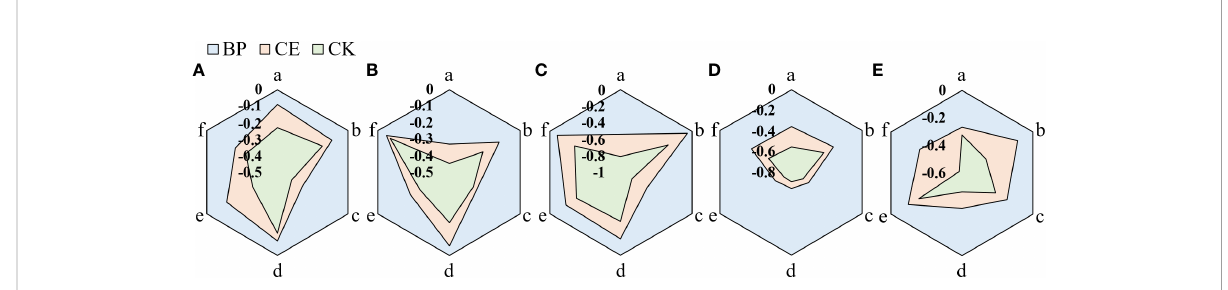
FIGURE 7 Allelopathic effect index of root exudates of Maize on the growth of seedlings of recipient plants. (A – E) shows the allelopathic effect index of CE and CK root exudates on the growth of radish, cucumber, lettuce, pepper, and ryegrass respectively. (a – f) in the fi gure respectively represent the allelopathic effect index of maize root exudates on the hypocotyl length, bacon length, fresh weight of hypocotyl, fresh weight of mating root, dry matter accumulation of hypocotyl, and dry matter accumulation of radicle of the recipient